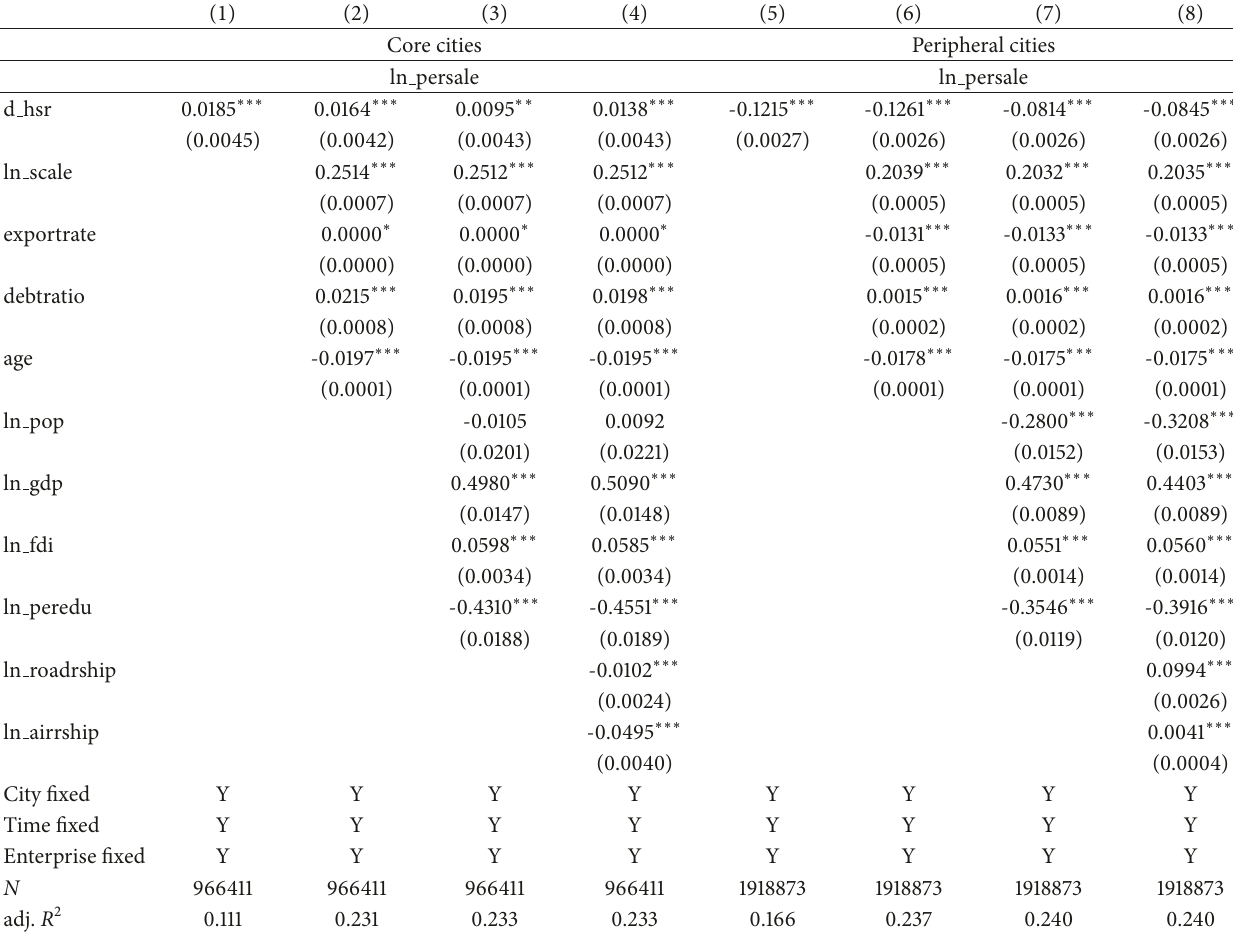
Table 5: The basic regression of enterprise productivity in core and peripheral cities.